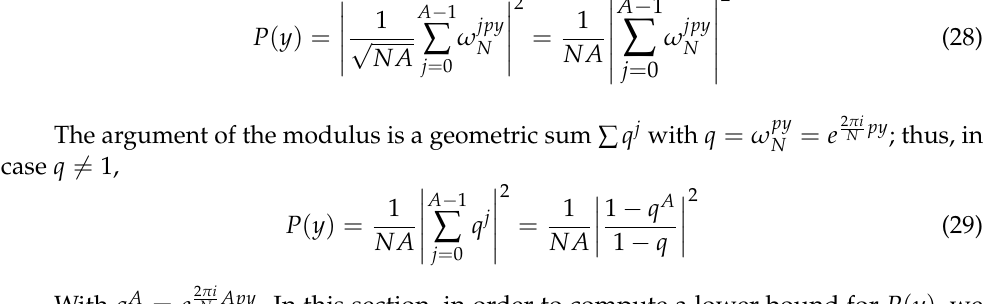
= 1 is below the graph of sin x 2 x (green in Figure 18). π ≤ sin ϕ for ϕ ∈ [ 0, π ] , and π 2